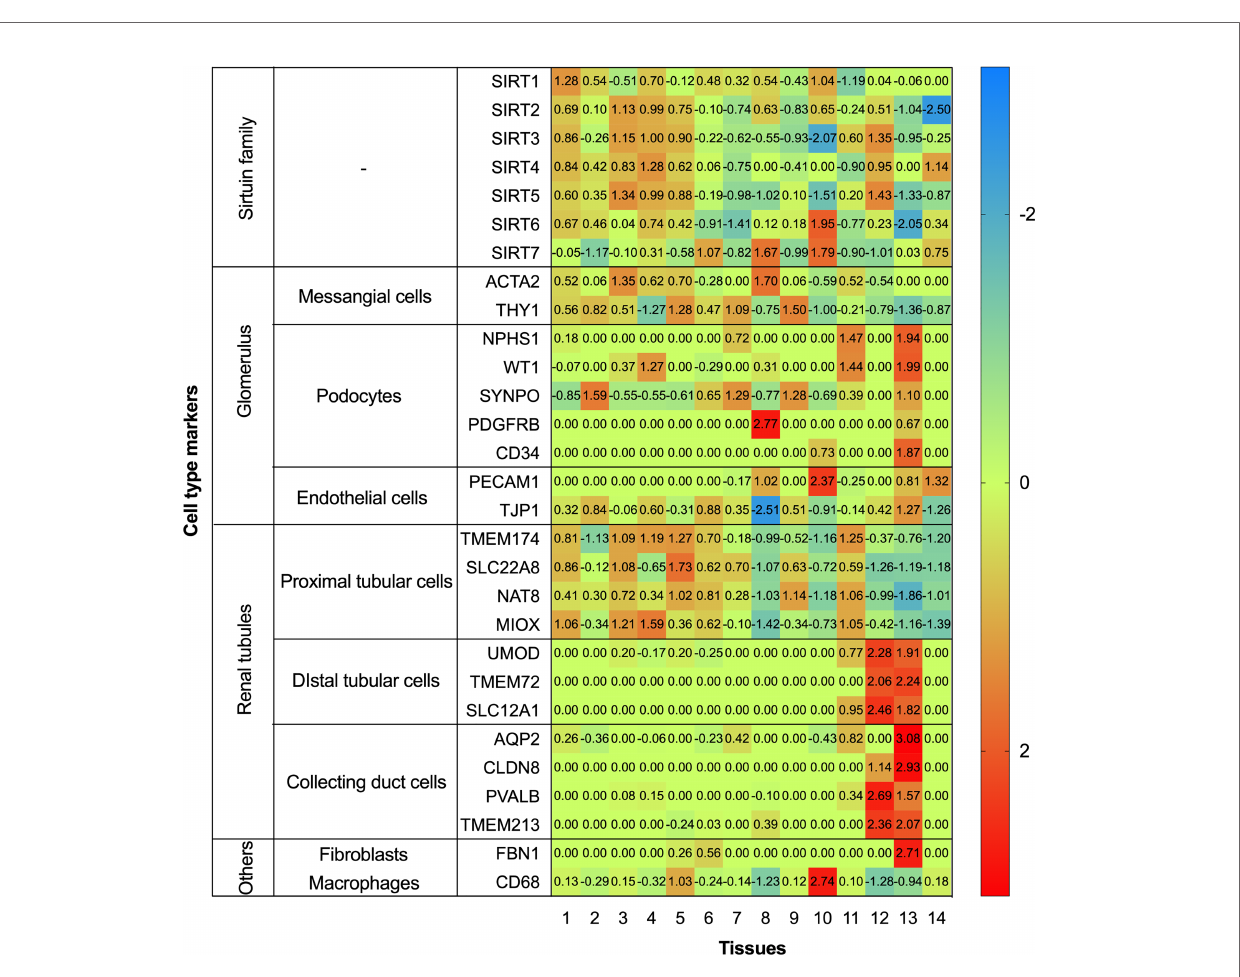
FIGURE 3 | Heatmap of human Sirtuin family genes with different cell type markers. Single cell transcriptomics data for kidney tissues and peripheral blood mononuclear cells were analyzed. These datasets were respectively retrieved from the Single Cell Expression Atlas (https://www.ebi.ac.uk/gxa/sc/home), the Human Cell Atlas (https://www.humancellatlas.org/), the Gene Expression Omnibus (https://www.ncbi.nlm.nih.gov/geo/), the Allen Brain Map (https://portal.brain-map.org/), and the European Genome-phenome Archive